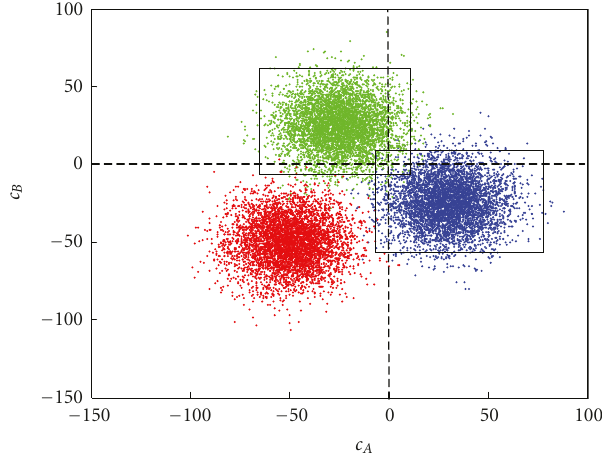
Figure 3: Distribution of the samples in the 2D output space.